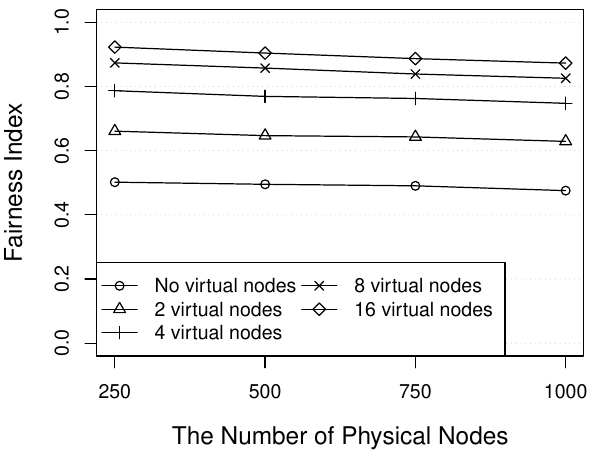
Figure 9. The fairness index of the number of the assigned data among physical nodes (random).